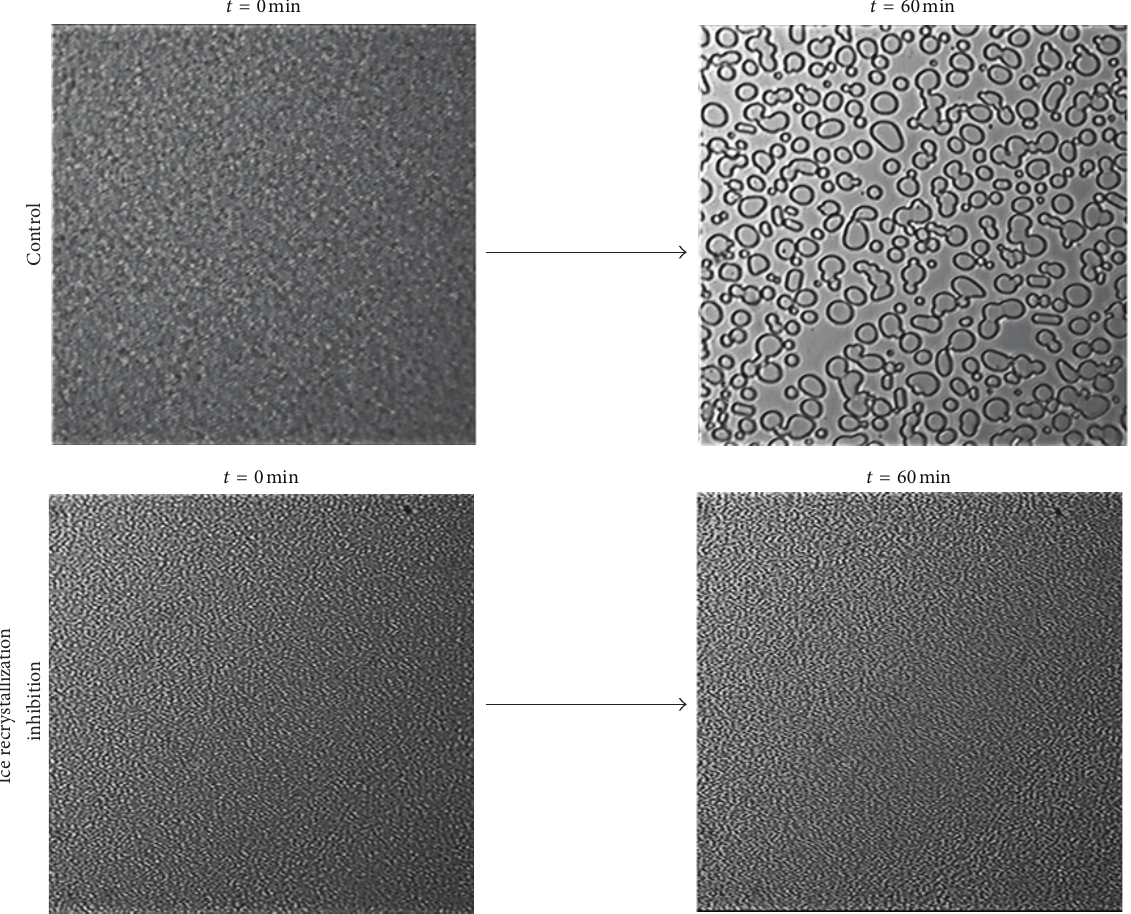
Figure 5: Ice recrystallization inhibition by antifreeze proteins. Flash frozen samples are held at − 6 ∘ C for 60 minutes. Following this wait, ice crystal size at both time points are compared. Top figures show large recrystallized ice using a control solution, consisting of 50 mM Tris (pH 8.0) and 50 mM NaCl. Bottom figures show ice recrystallization inhibition using an antifreeze protein solution containing 0.1mg/mL AfpA in control